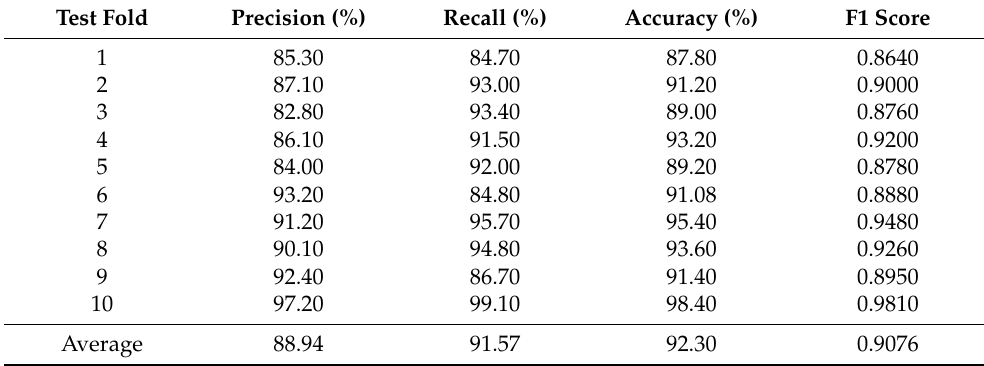
Table 10. Experimental results of K-fold cross-validation ( K f = 10) for Model #1–1 with 4 Kernel